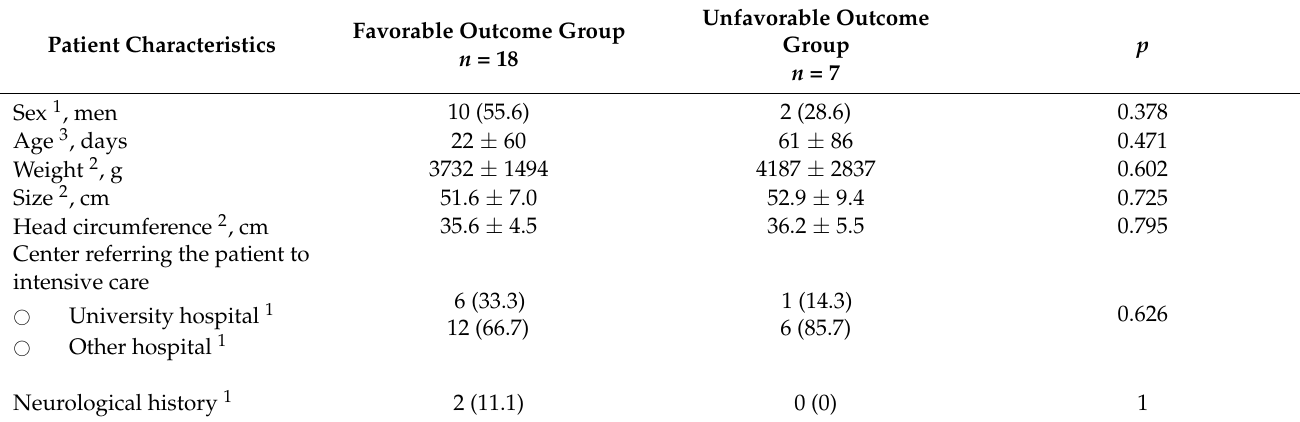
Table 1. Characteristics of patients included in the study, according to outcome